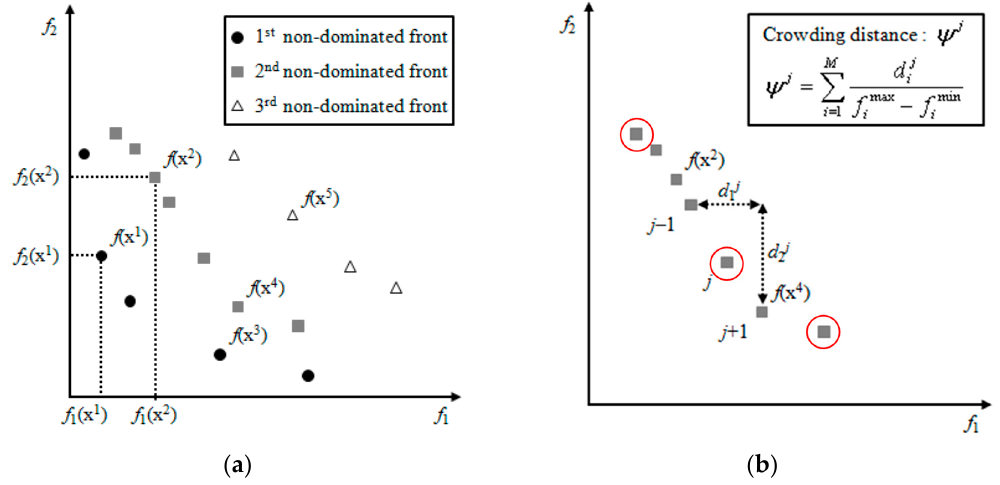
Figure 4. Ranking evaluation using NSGA-II for a bi-objective minimization problem: ( a ) non-dominated sorting; and ( b ) crowding-distance sorting.